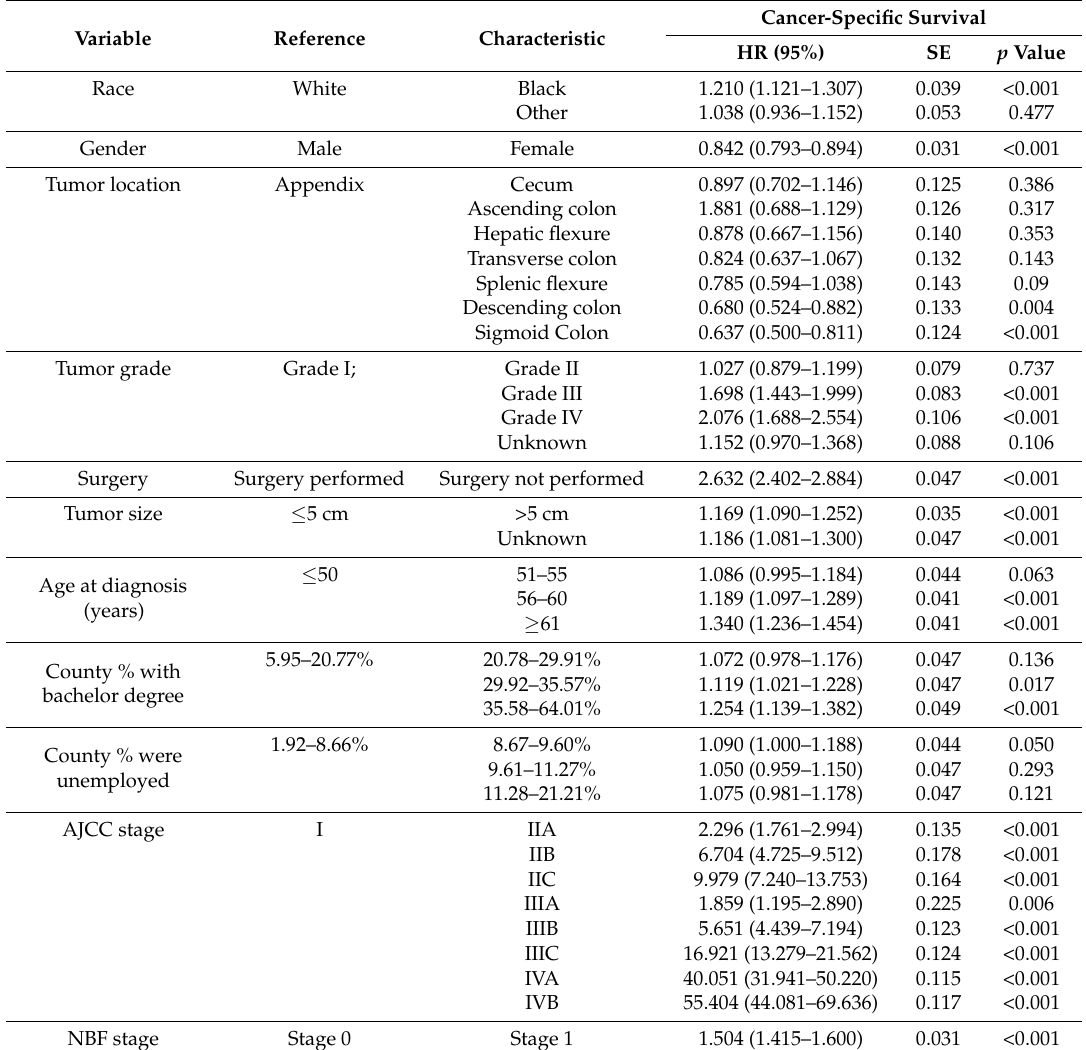
Table 3. Multivariable Cox regression analyses of independent prognostic factors in colon